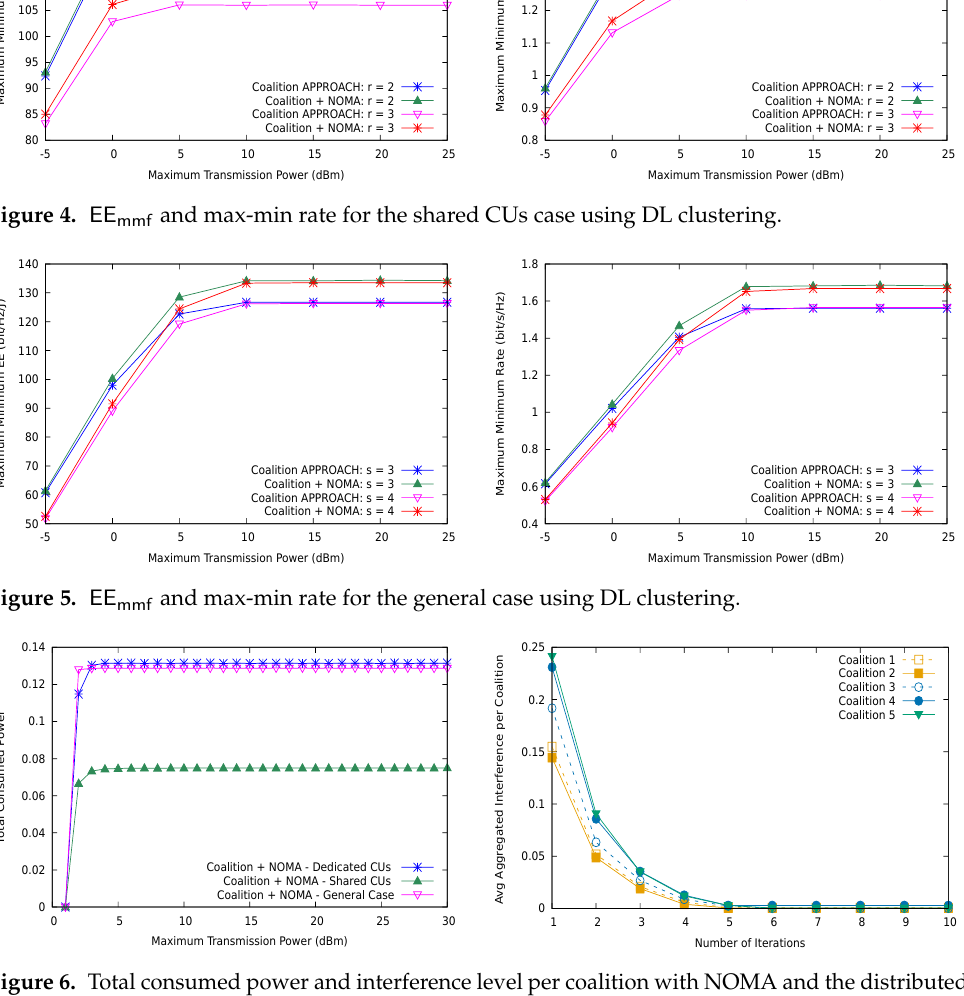
Figure 6. Total consumed power and interference level per coalition with NOMA and the distributed coalition